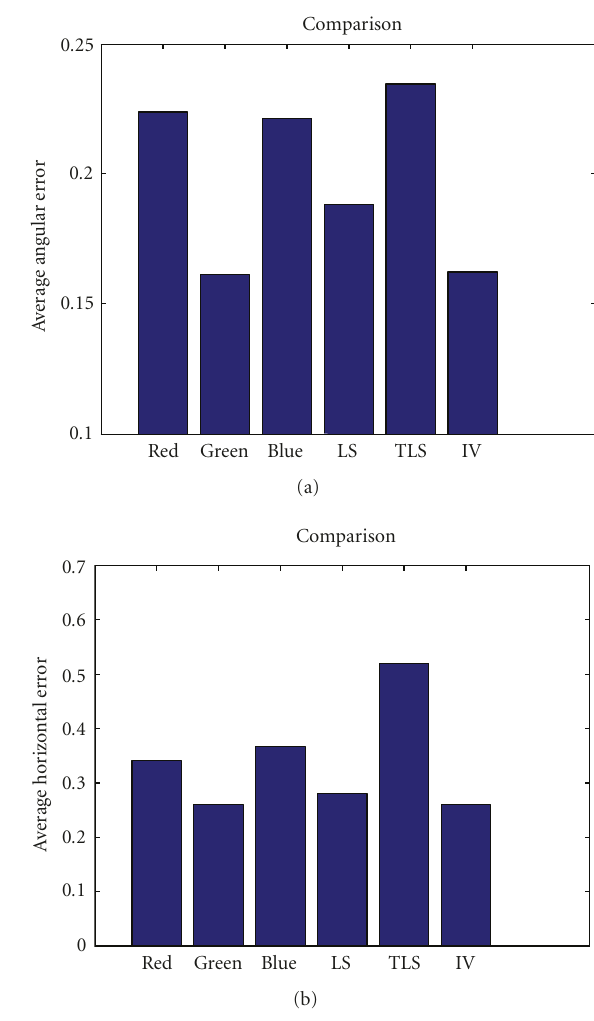
Figure 8: Performance comparison on the “wall” sequence: (a) Av- erage angular error (in degrees) between estimation and ground truth. (b) Average relative error in value of horizontal flow com-